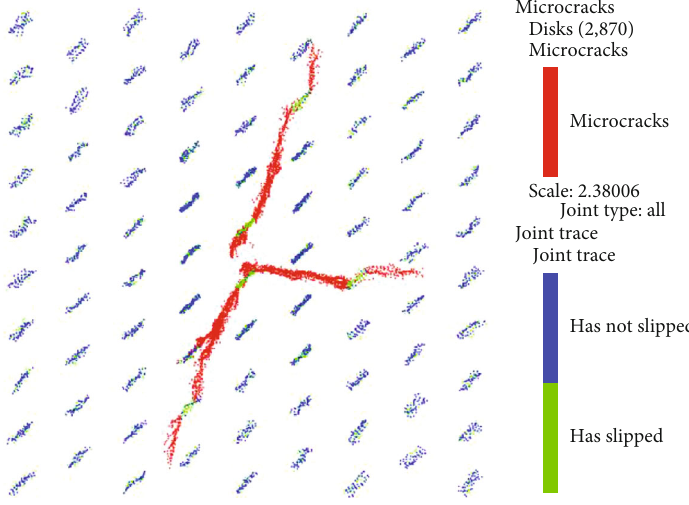
Figure 19: Microcracks in intact rock and shear slip on NFs for θ = 45 ° .